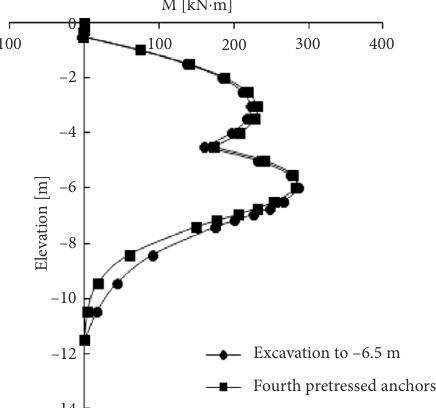
Figure 9. Evolution characteristics of bending moments of cast-in-situ piles during excavation to –11.5